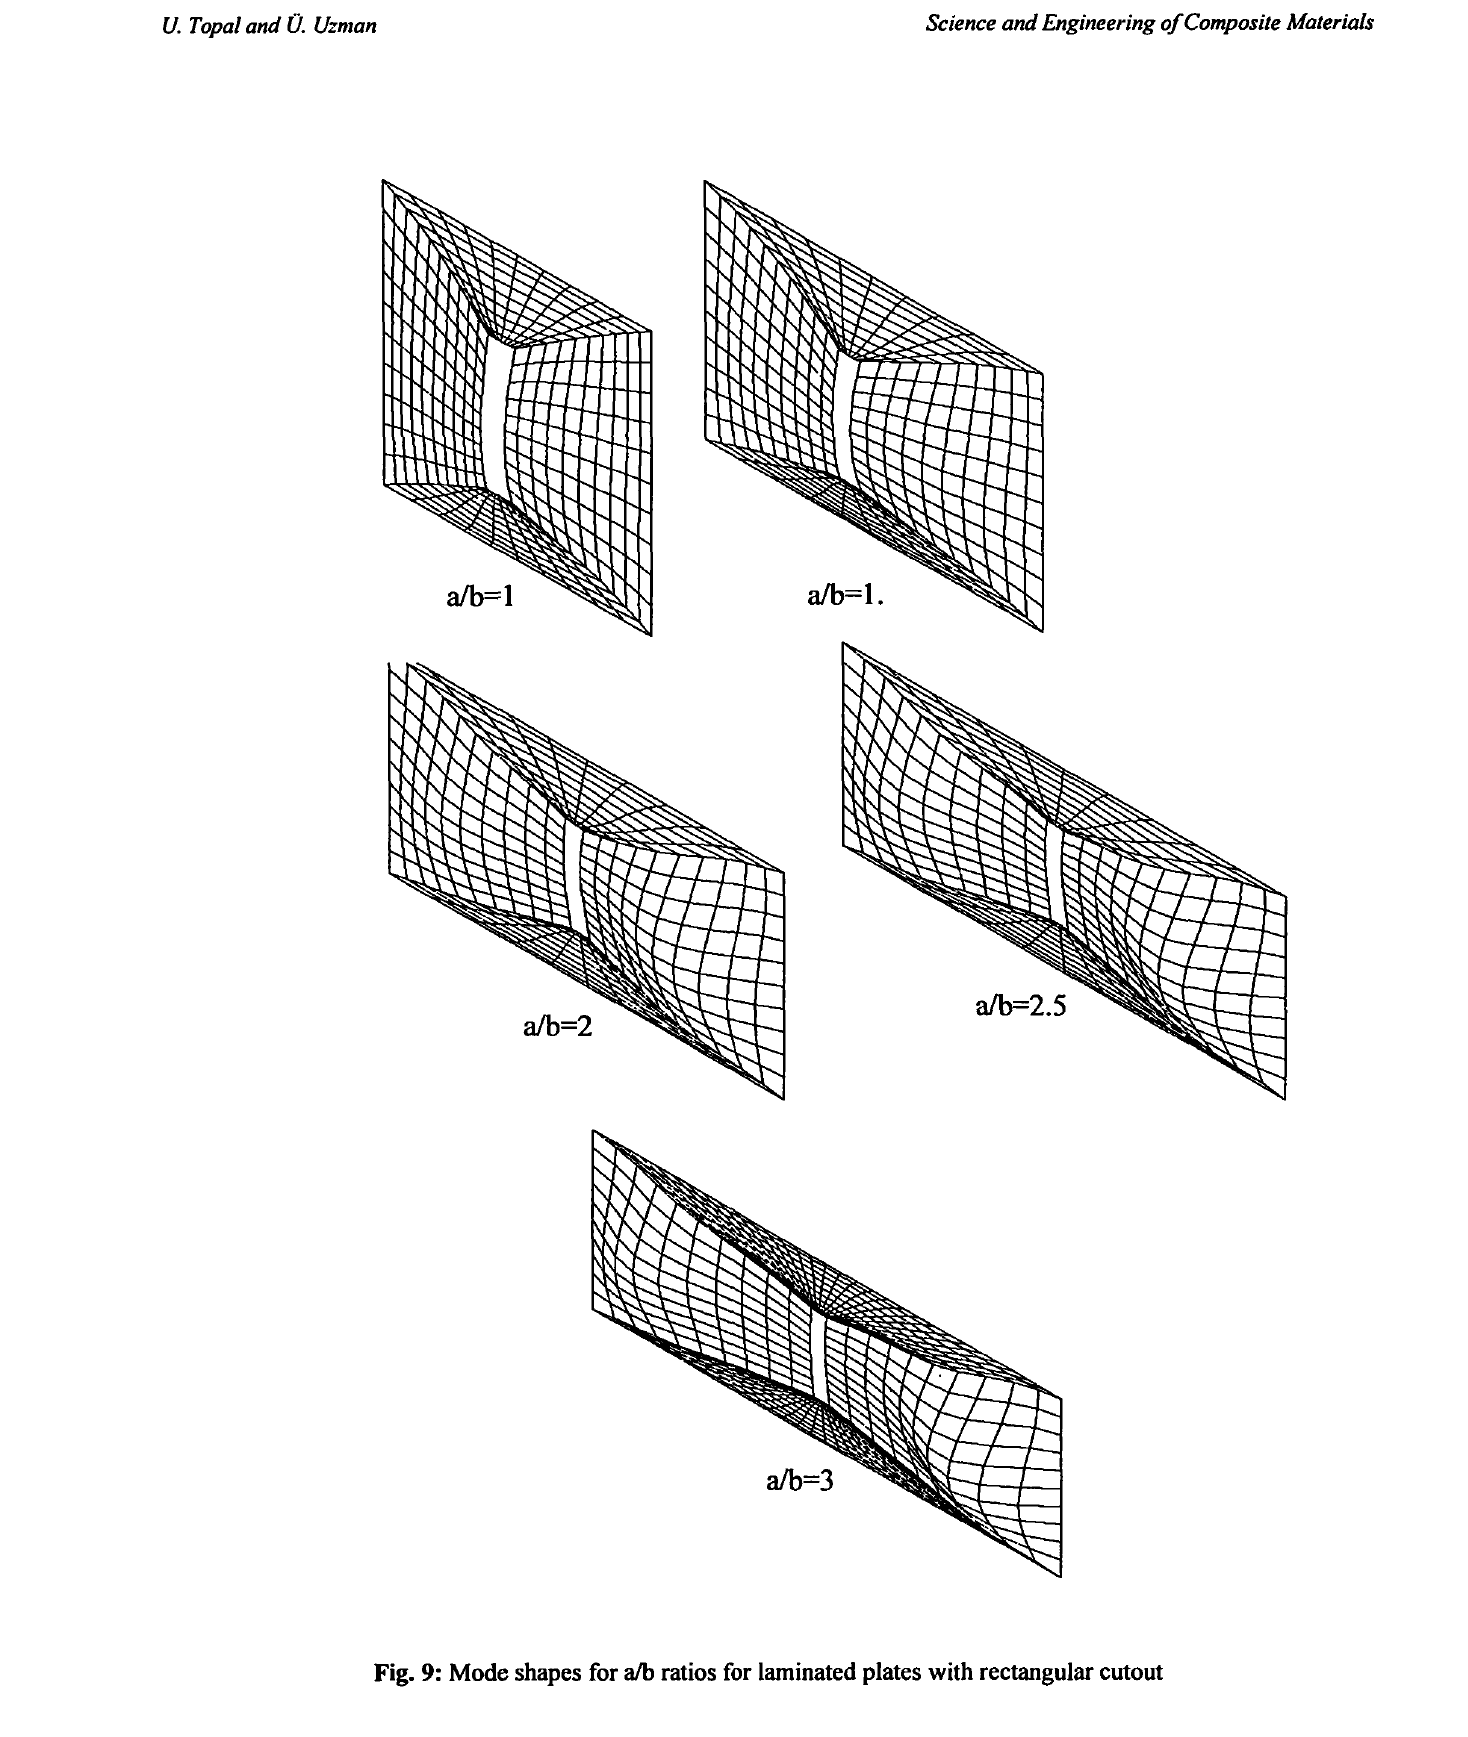
Fig. 9: Mode shapes for a/b ratios for laminated plates with rectangular cutout